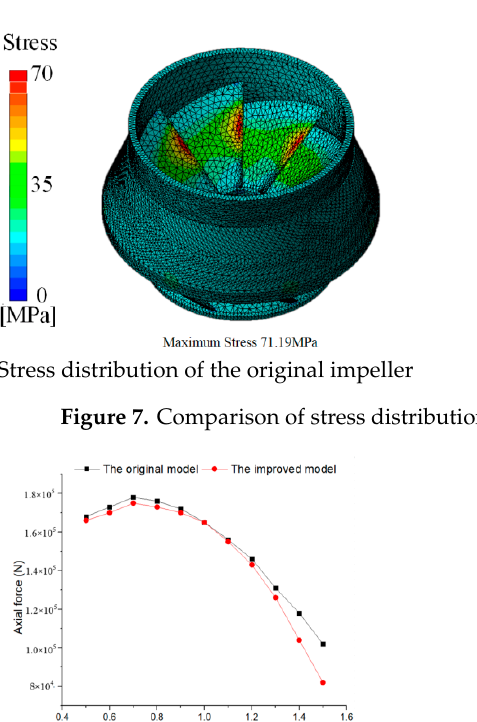
Figure 6. Comparison of natural vibration modes before and after impeller improvement.